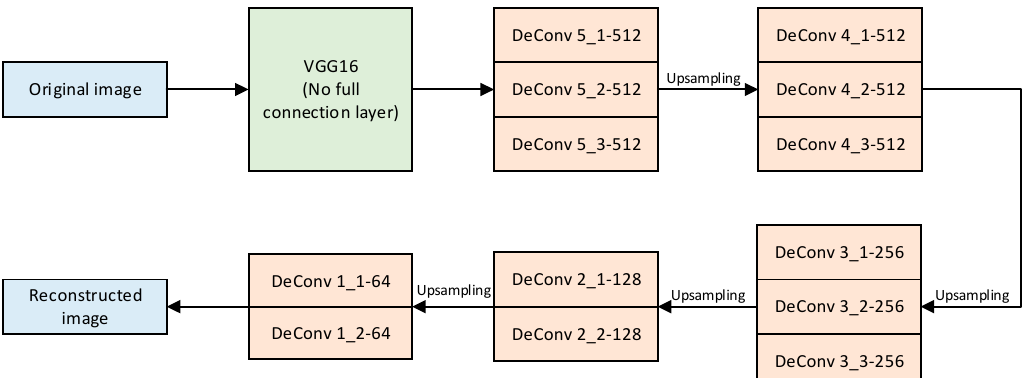
Figure 6. Structure and parameters of the convolution autoencoder based on VGG16.